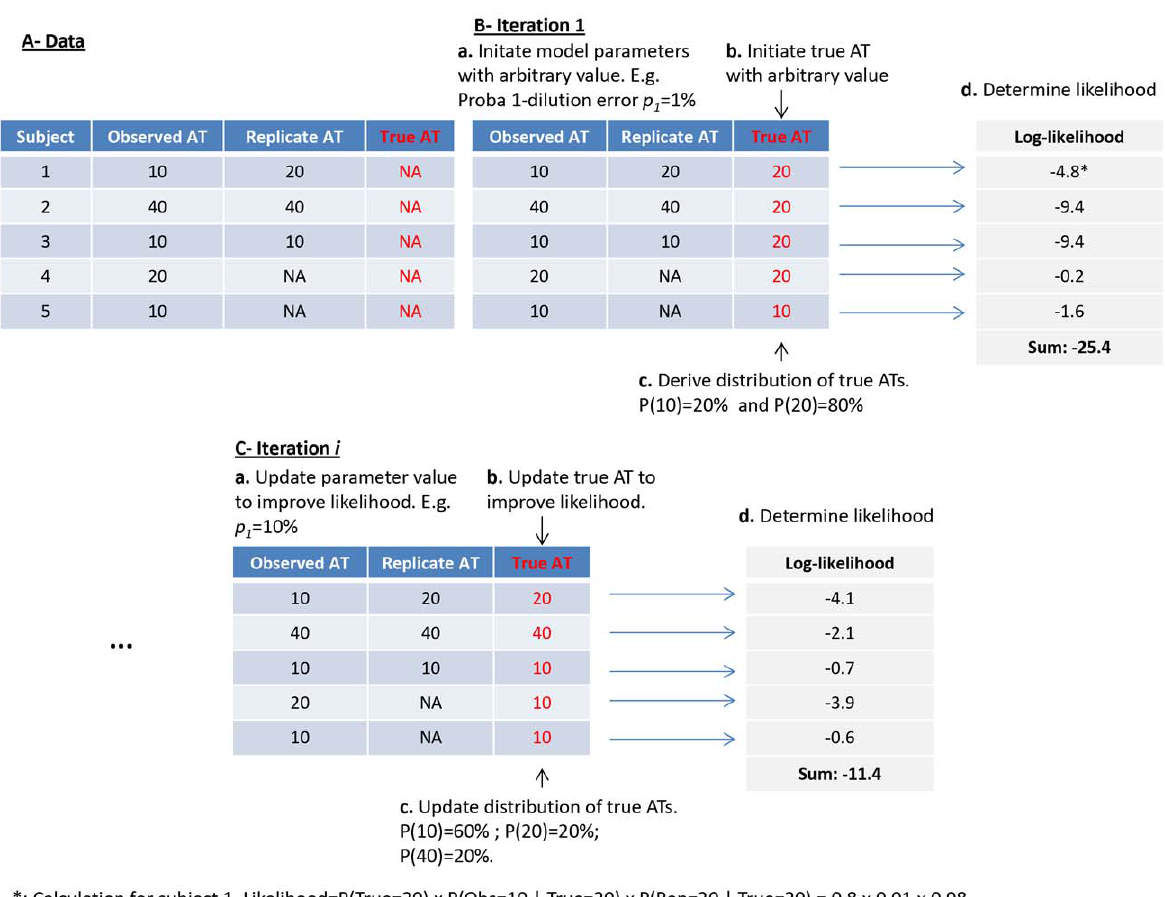
Figure 7. Less technical description of the statistical method. This figure illustrates the description of the method that is made in Box 1.